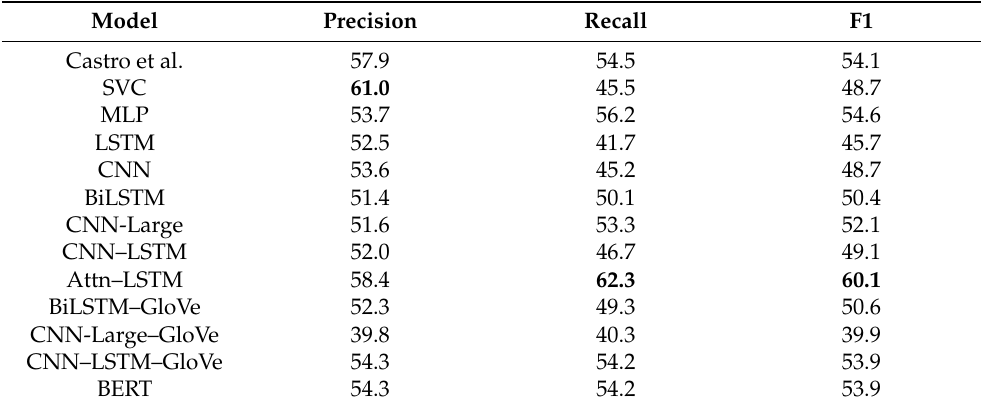
Table 3. Model’s results. Bold highlights the best result for the specific metric (column).